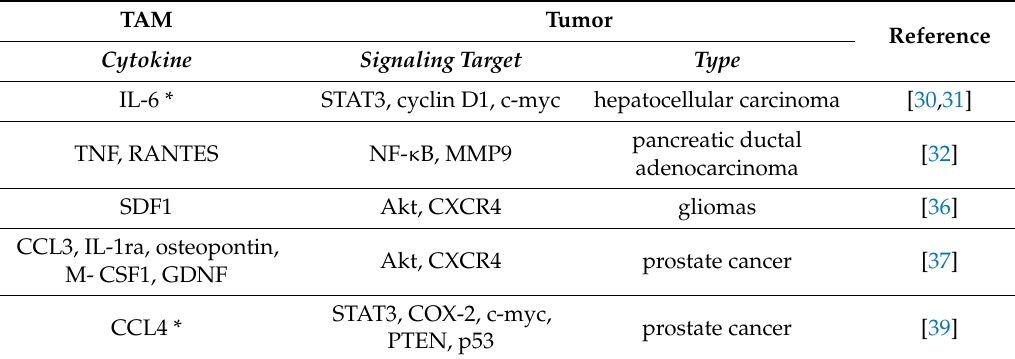
Table 2. Summary of cytokines and their signaling targets leading to cancer initiation.